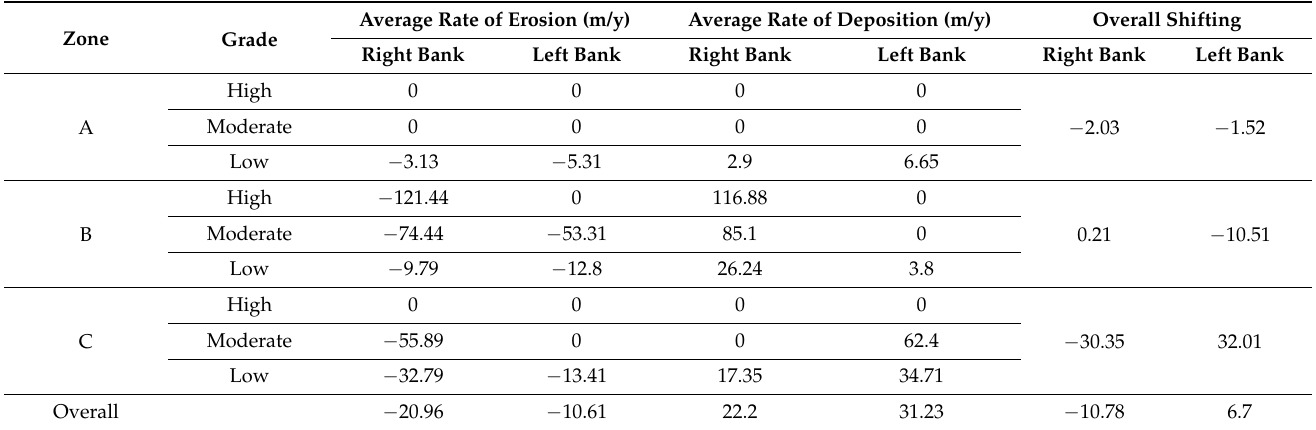
Table 5. Bank shifting rate of the Jia Bharali River using LRR approach of DSAS